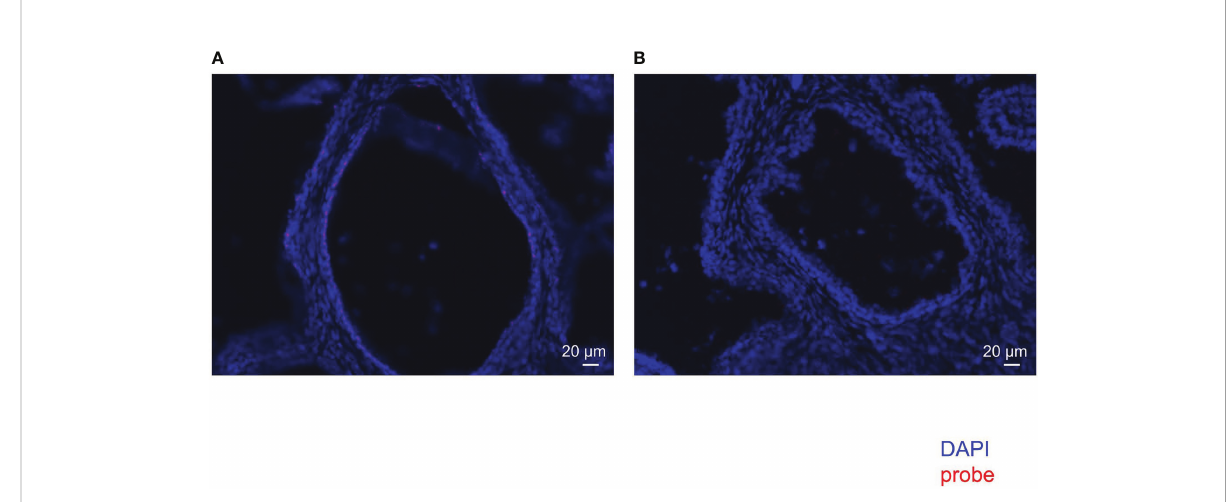
(Figure 2A) showed eubacterial signals but FISH with NON338 (Figure 2B) showed no eubacterial signal. These results demonstrated the presence of the prostate microbiota.